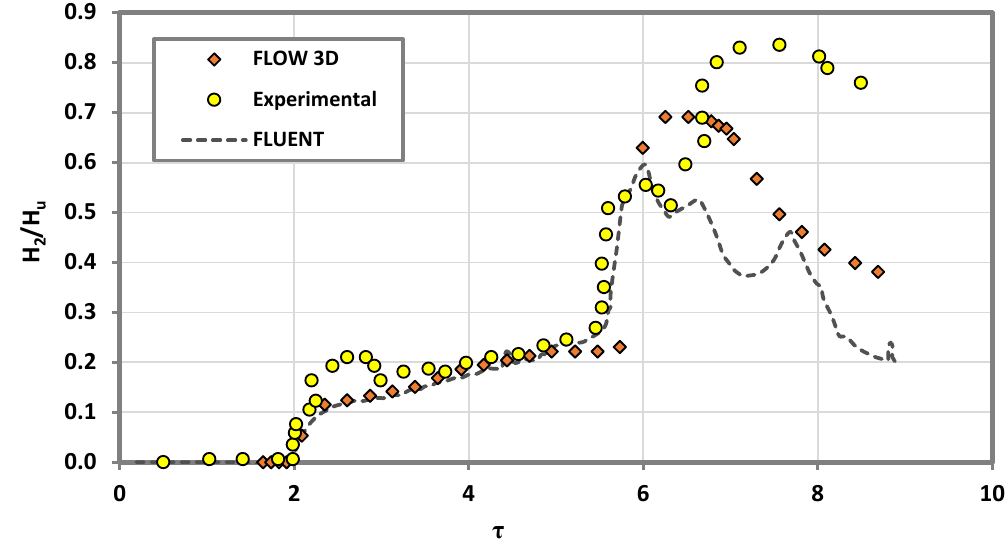
Fig. 7. Comparison of water level at 2.725 (m) using numerical models and experimental